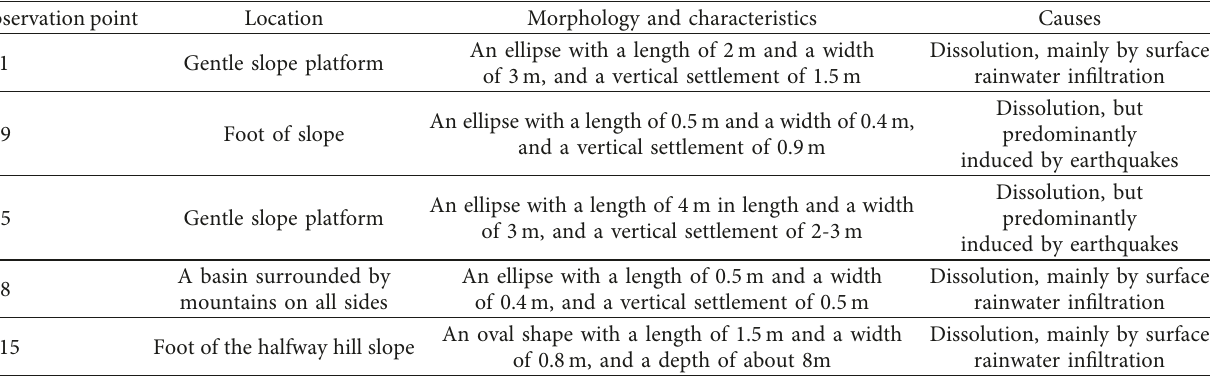
Table 1: Features of the karst collapse points (or funnels) in the study area.